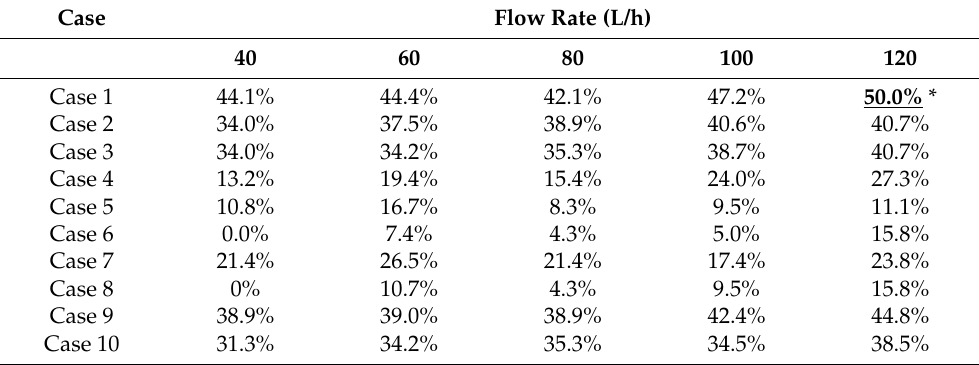
Figure 7. Pumping power for considered cases at the inlet temperature of 20 °C for flow rates of ( a ) 40 and ( b ) 120 L/h. Table 4. Size reduction by using metal foam at different flow